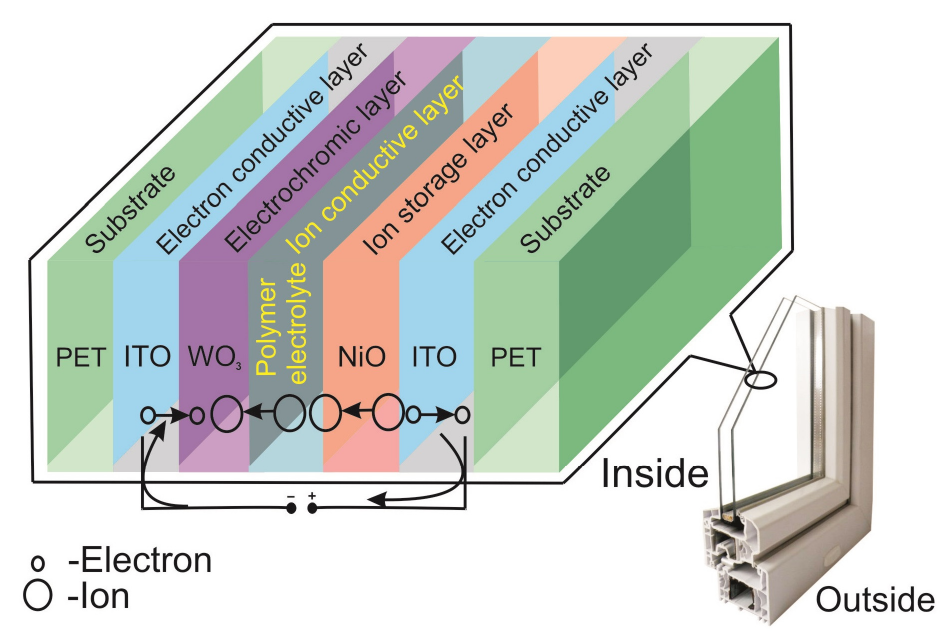
Figure 19. ECW scheme showing voltage-induced transfer of positive ions and electrons to transpar- ent conductive layers.